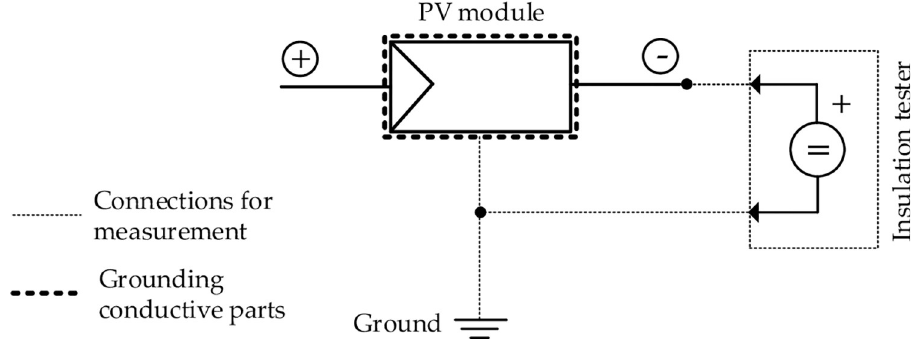
Fig 6. Measuring of leakage current of PV